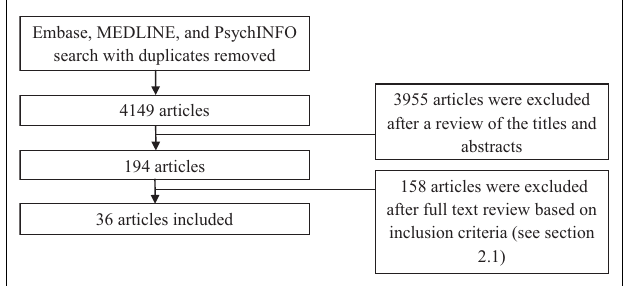
FIGURE 1 | Selection of articles for inclusion . Note: diagnostic grouping of studies do not add to 36 due to some studies reporting on multiple